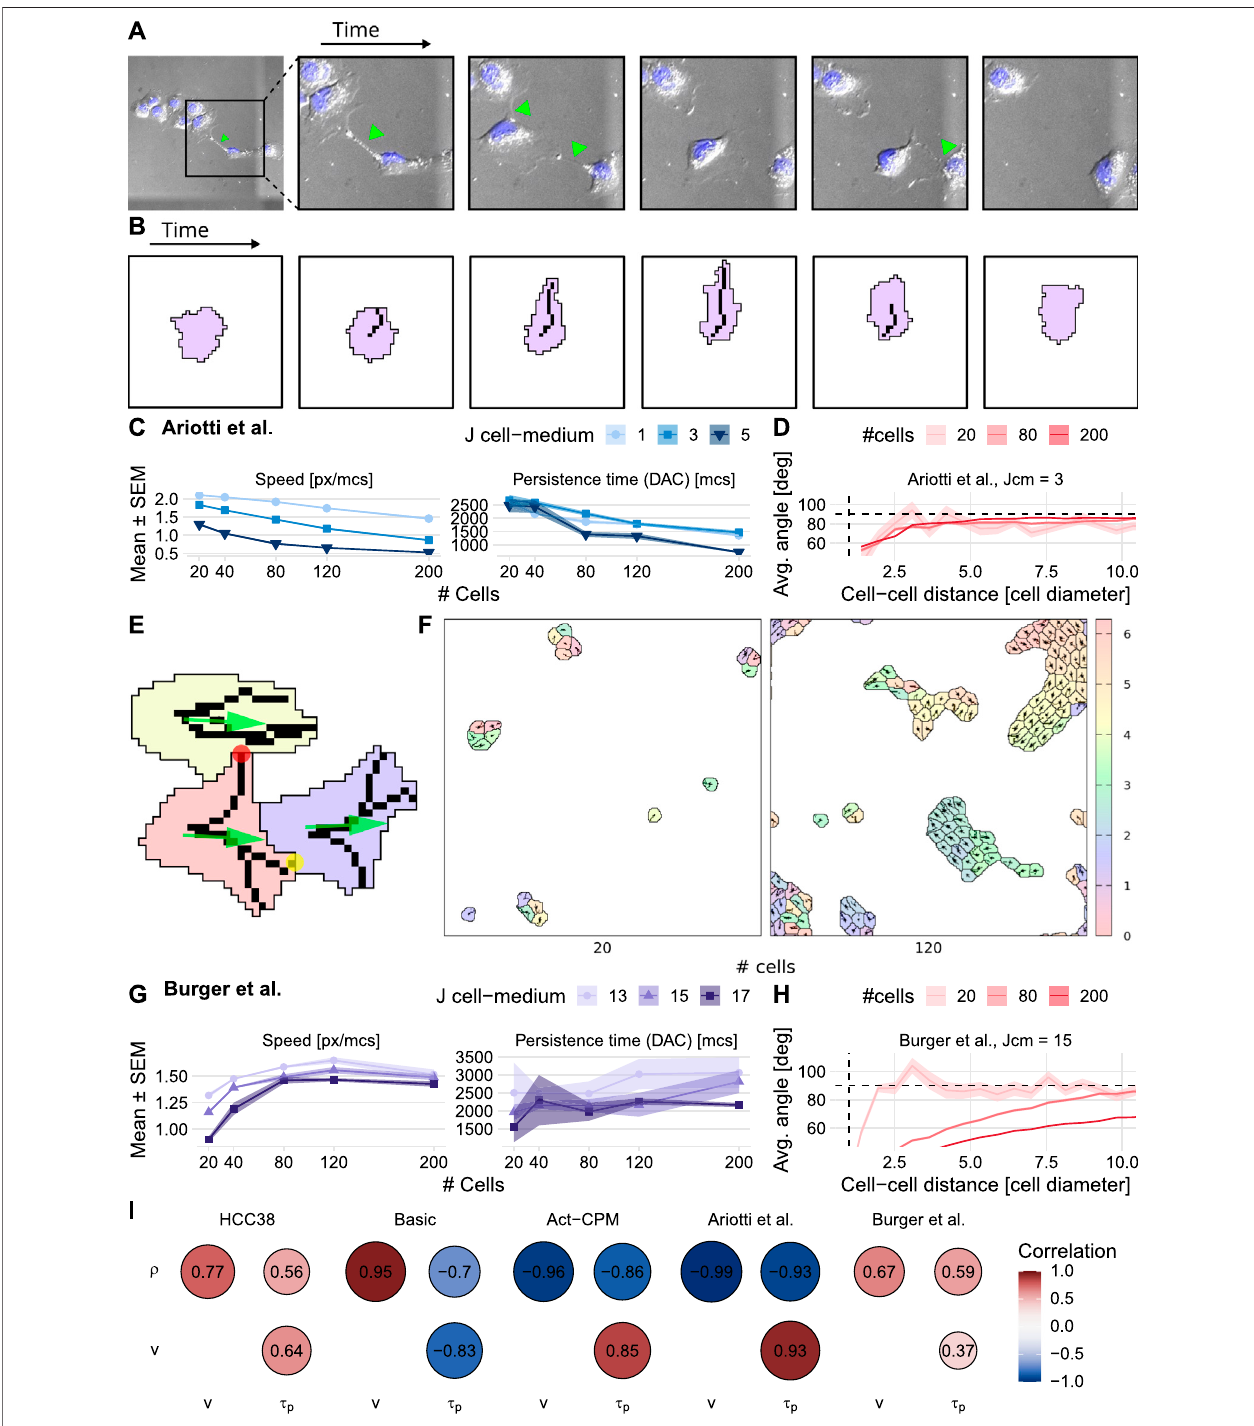
FIGURE 5 | Effect of cell density on cell speed and persistence simulated using pseudopod-driven CPM persistence models. (A) Example of HCC38 cells at low density crossing a cluster using pseudopods (green arrows). (B) Illustration of how modeling protrusion/retraction of an actin fi ber in a cell drives pseudopod-driven motility. (C) Results from the base pseudopod-driven model by Ariotti et al. (2012) (D) Stream formation in model by Ariotti et al. (2012) (E) Mechanisms added in the proposed model: pseudopod tips that are more adhesive (yellow circle), a pulling force in combined direction of the pseudopods (green arrows), and Contact Inhibition of Locomotion-like pseudopod interaction (red circle). (F) Snapshot of simulations using the proposed pseudopod-driven persistence model. Densities are comparable to HCC38 plated density of 20,000 and 50,000 (cf. Supplementary Figure S1 ). (G) Speed (left panel) and persistence (right panel) resulting from the proposed pseudopod-driven model. (H) Stream formation in the proposed pseudopod-driven model for different simulated cell numbers. (I) Correlograms comparing the different persistence models to the experimental correlations ( ρ : density, v : speed, τ p : persistence time). Horizontal dashed lines in (D) and (H) denote theoretically expected average angle, vertical dashed lines show approximate cell